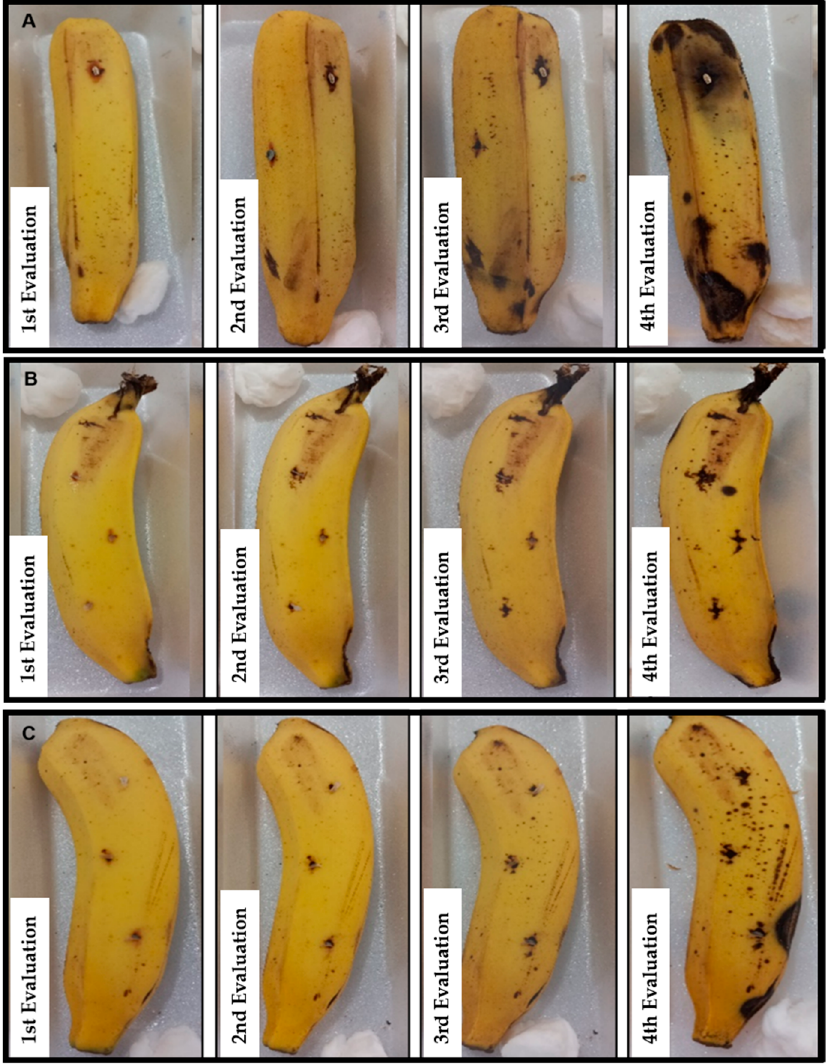
Figure 6. Banana fruits not treated and preventively treated with the coumarin standard and inoculated with Colletotrichum musae . ( A ) Fruits sprayed with water and inoculated with phytopathogen (control). ( B ) Fruits sprayed with coumarin (40%) and inoculated with the phytopathogen. ( C ) Fruits sprayed with coumarin (50%) and inoculated with phytopathogen, in four evaluations.